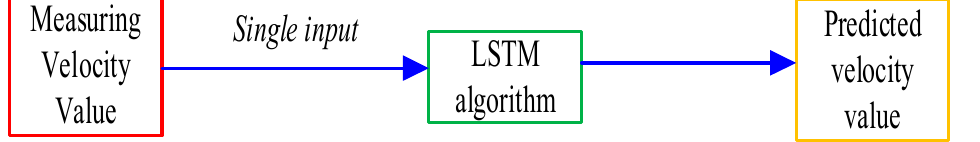
Figure 2. Diagram of a traditional single input tidal current prediction method.